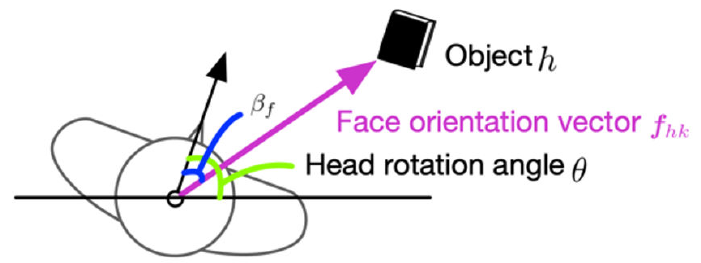
Figure 6. Vector and angles used to identify face